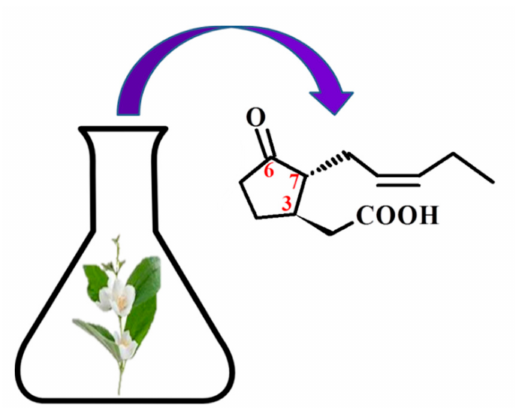
Figure 1. The structure of trans-(-)-(3R,7R)-jasmonic acid. There are four known stereoisomers of jasmonic acid: trans -( − )-(3 R ,7 R ), abbreviated as ( − )-JA; trans -(+)-(3 S ,7 S ) abbreviated as (+)-JA; cis -( − )-(3 S ,7 R ) abbreviated as ( − )- epi -JA; cis -(+)-(3 R ,7 S ) abbreviated as (+)- epi -JA [15]. The naturally occurring jasmonic acid in plants is ( − )-JA and (+)- epi -JA. Due to the fact that the cis stereoisomers are thermodynamically less stable, they epimerize at the C-7 atom to the stable trans form, which at the same time shows a higher biological activity. The biological activity of jasmonic acid has been found to be dependent on the presence of a carboxyl group at the C-1 position, a keto or hydroxyl group at the C-6 position, and a pentenyl side chain at the C-7 position [16–18]. Because